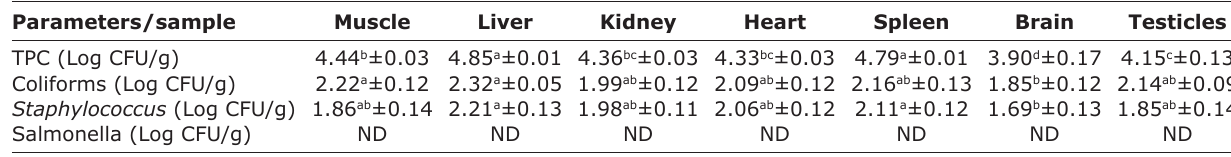
Table-3: Microbial counts (log10 CFU/g) in different edible by-products and longissimus dorsi muscle of Barbari kids